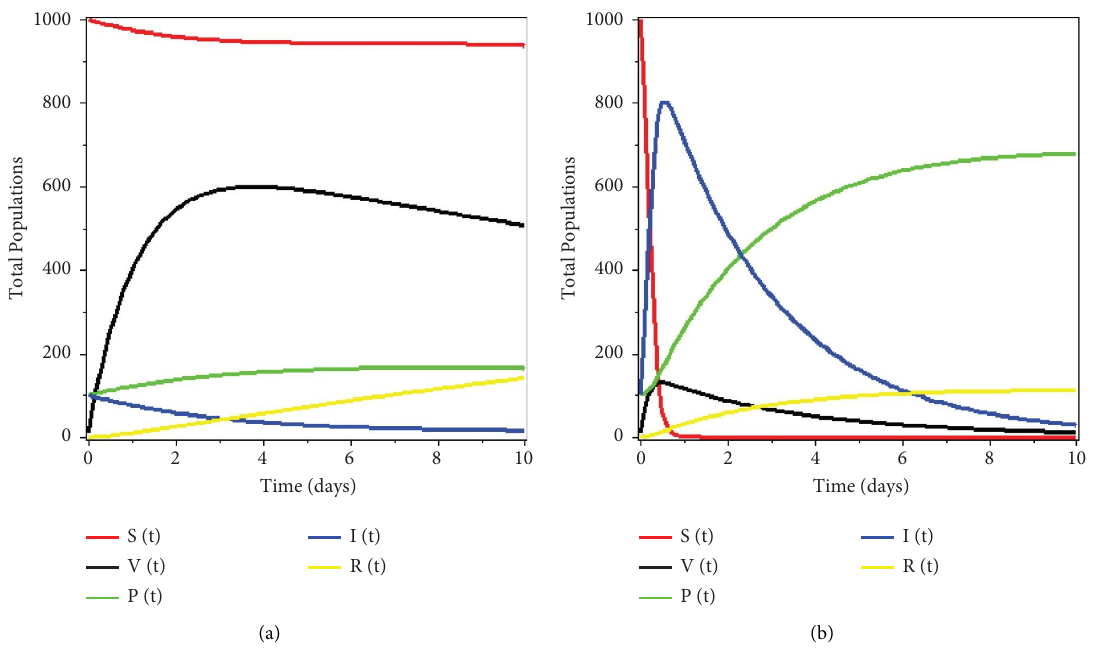
Figure 2: Graphical representation of the total population when R